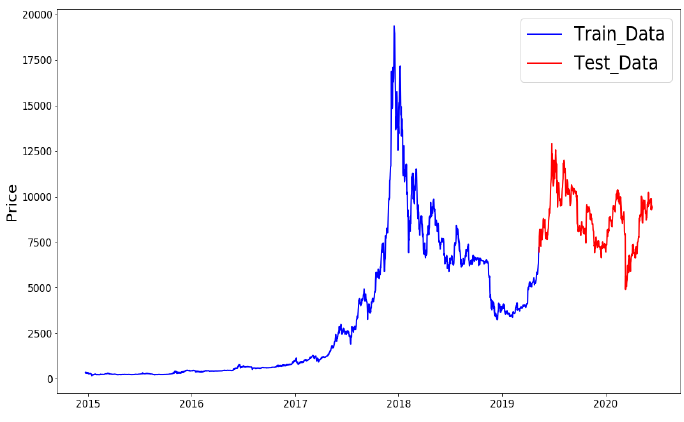
Fig. 6 . Status of train and test data (part of data).